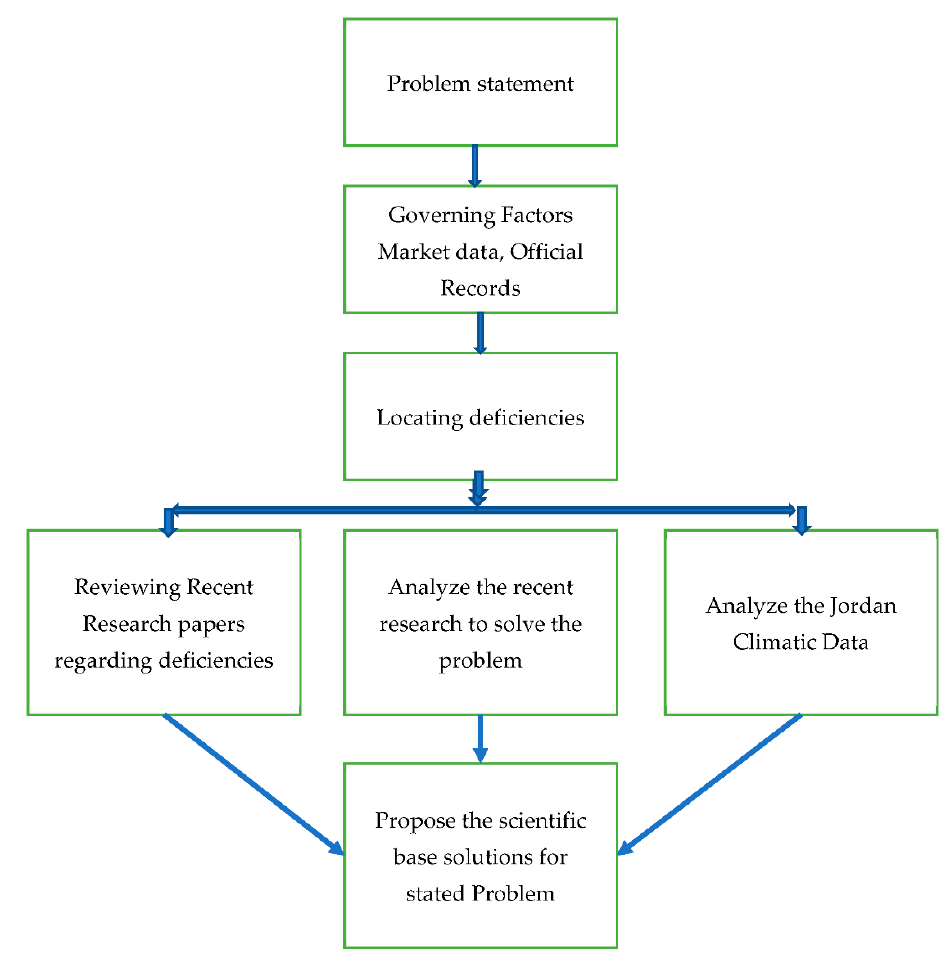
Figure 2. Methodological framework for the research performed.